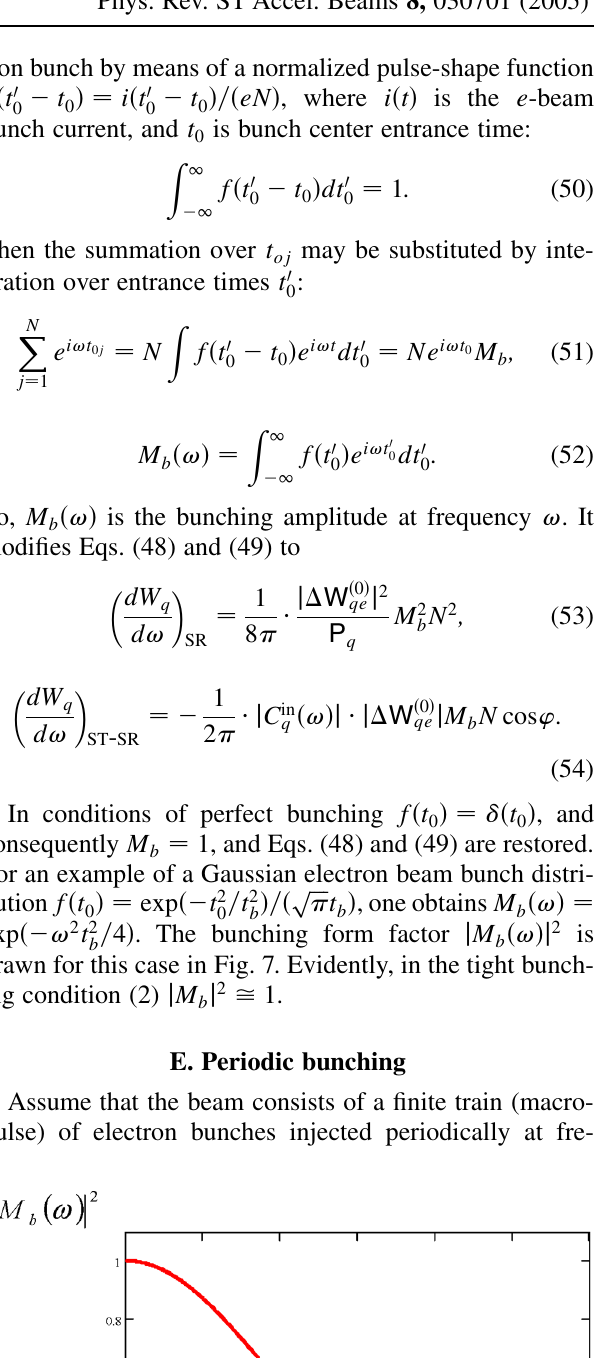
FIG. 7. (Color) The bunching form factor j M = 2 (cid:5) for a Gaussian e -beam bunch distribution f (cid:4) t exp (cid:4)(cid:14) ! 2 t 2 p b (cid:5) = (cid:4) (cid:7)(cid:7)(cid:7)(cid:7) (cid:6) (cid:5) =t 2 t exp (cid:4)(cid:14) t 2 b b 0